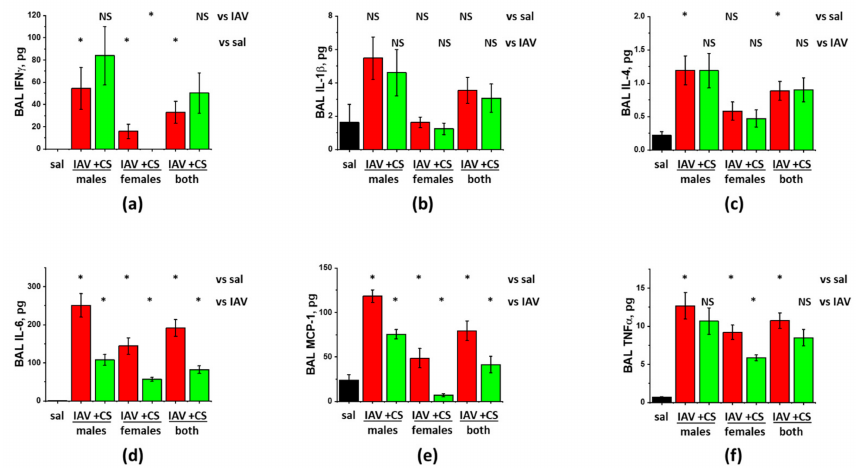
Figure 4. ASC-CS administration limits inflammatory cytokine increases in BAL of IAV-infected mice. C57Bl/6 mice received intranasal administration of IAV H1N1 PR8 (800 pfu/mouse) on Day0. Mice receiving vehicle control for IAV are annotated as saline (sal, black columns). On Day6 and 8, IAV mice were sub-cutaneously injected with 2.25 mg/kg of ASC-CS (CS, green columns) or an equivalent volume of PBS (red columns designated as IAV). BAL fluids were collected on Day9 to analyze for IFNy ( a ), IL-1b ( b ), IL-4 ( c ), IL-6 ( d ), MCP-1 ( e ), and TNF α levels ( f ). n = 4–6 per group, presented are mean +/ − SEM. * for p < 0.05 by t -test with Welch correction (unequal variances) between (1) IAV groups and the control group (vs. sal), and (2) CS groups and the corresponding gender IAV group (vs. IAV). NS - differences between the groups are not